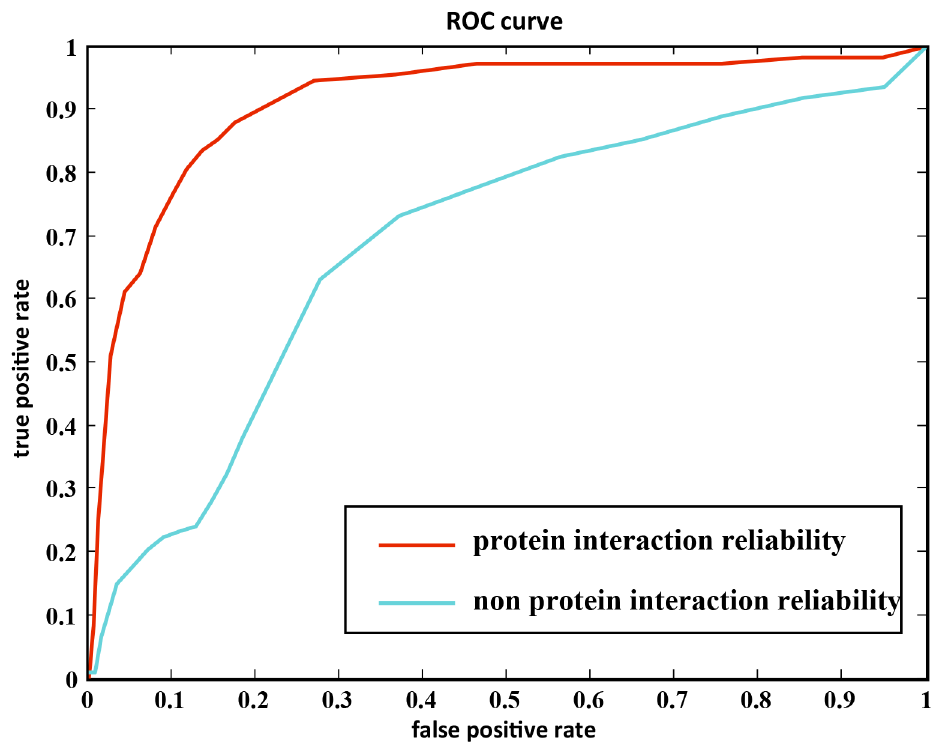
Fig 11. The ROC of the weight with protein interaction reliability and non-protein interaction